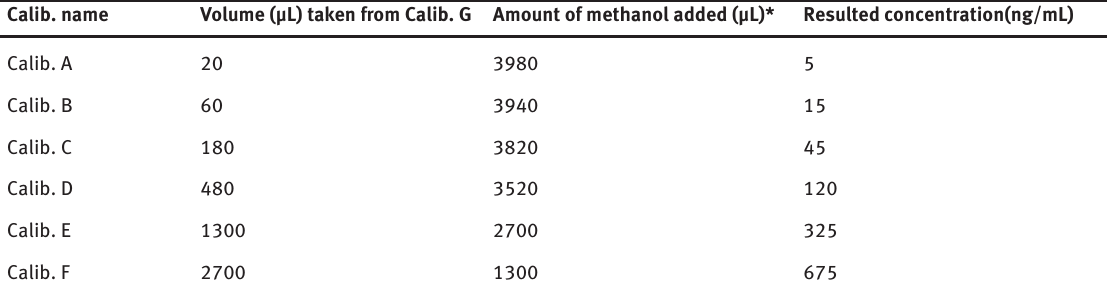
Table 1: Procedure for preparation of plasma working standard solutions. Calib.